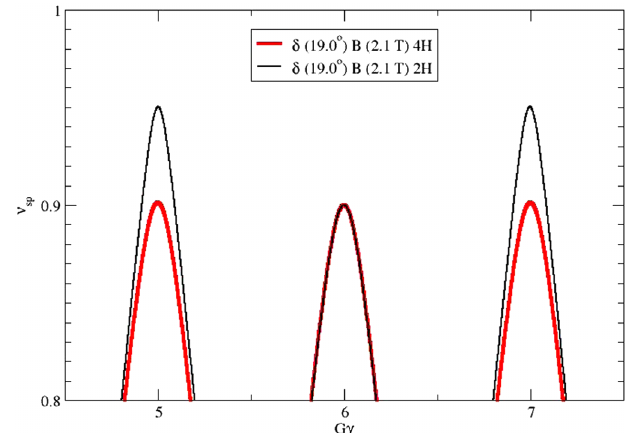
FIG. 6. The fractional part of the spin tune generated by four helices (red curve) each at a field of 2.1 T, and by two helices (green curve) of 2.1 and 1.5 T, respectively, as they are presently installed in AGS.